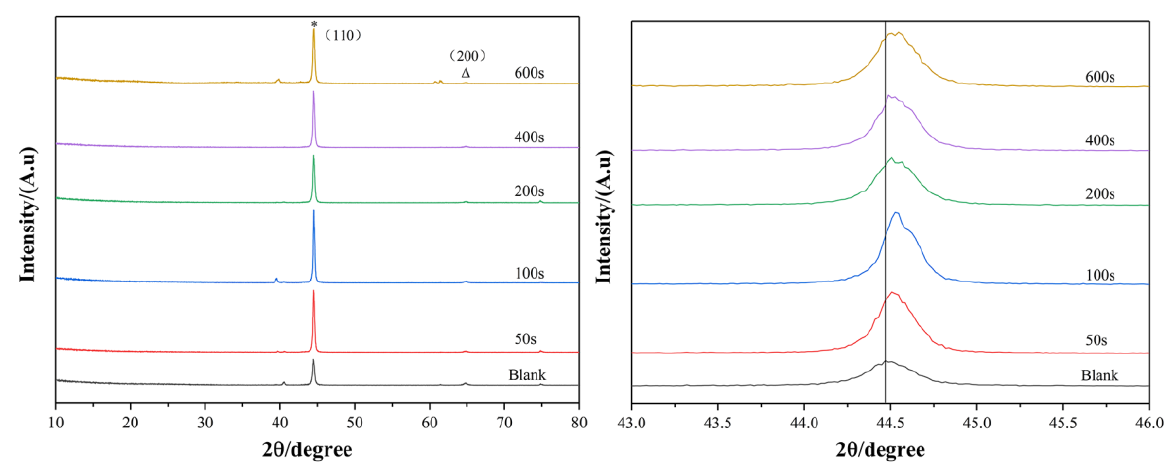
Figure 6. XRD patterns and enlarged images of samples with different shot peening times.